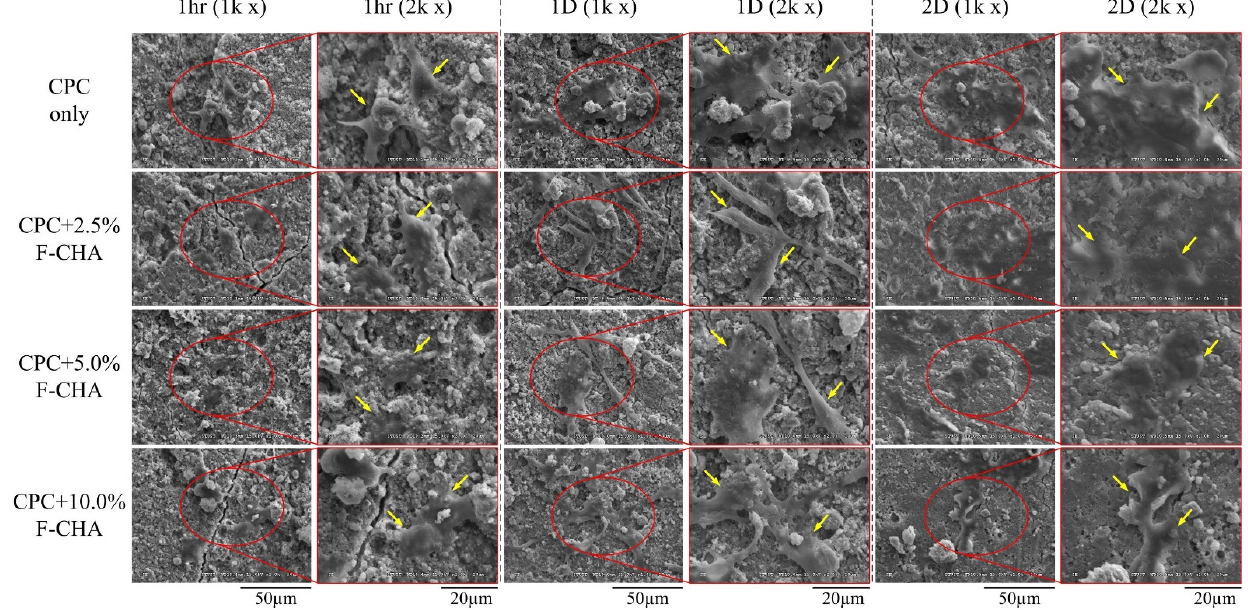
Figure 11. Morphologies of D1 progenitor bone cells cultured on the surfaces of CPC only and CPC composites with different ratios of ferulic acid-carbonated apatite nanorods for 1 h, 1 day, and 2 days.